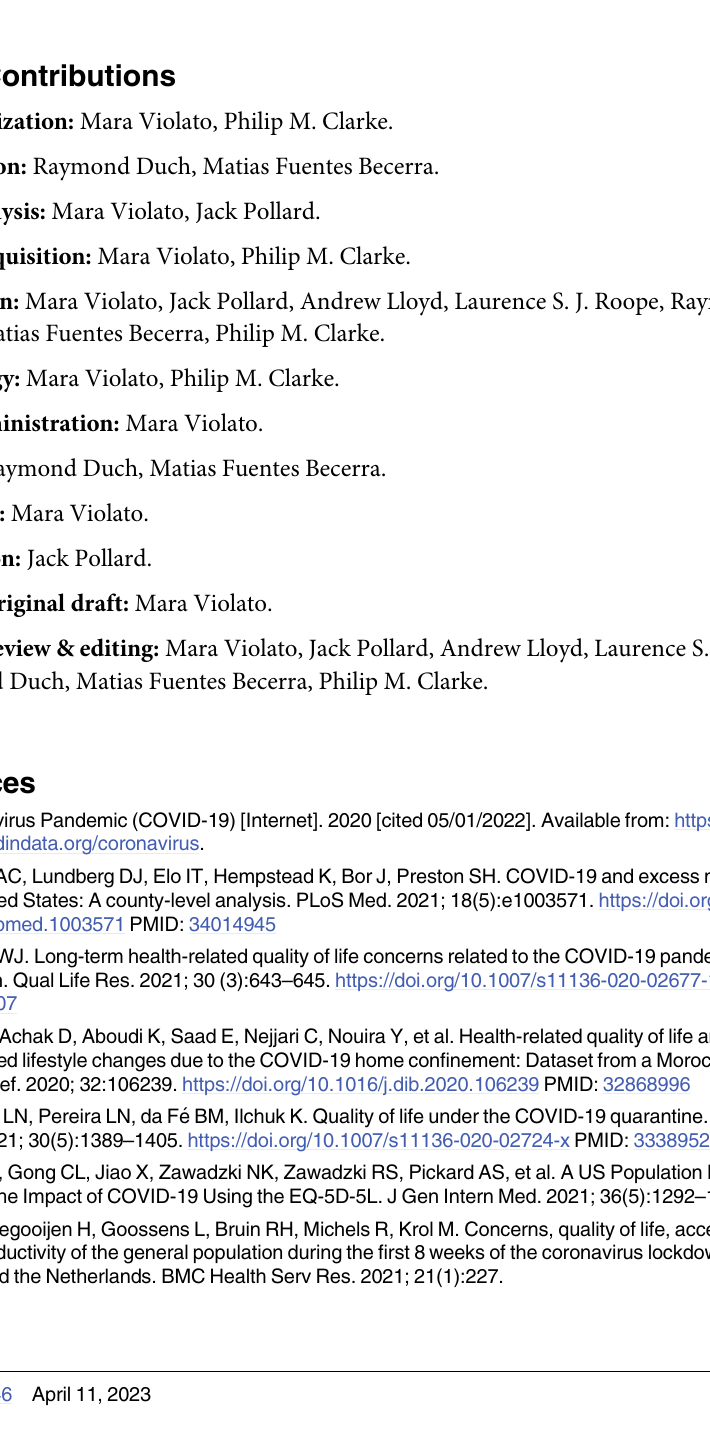
S10 Fig. Worsened anxiety/depression by age and gender for each continent. (DOCX) S11 Fig. Worsened health by EQ-5D domains but anxiety/depression—Stratified for by age and gender. (DOCX) S12 Fig. Respondents’ self-reported health on EQ-5D-5L before the COVID-19 pandemic and at time of survey—Overall